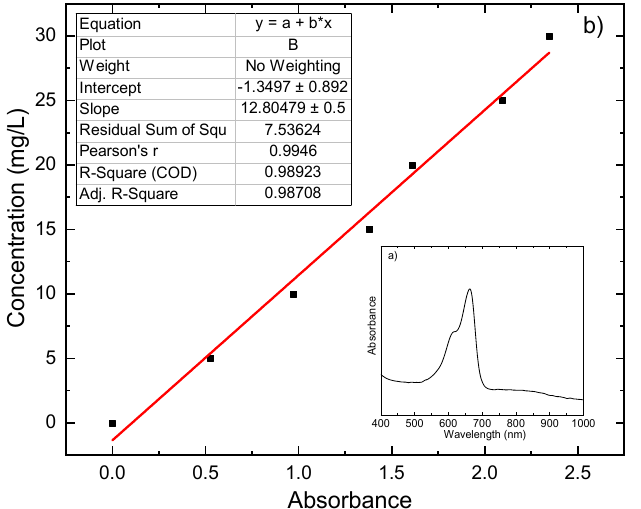
Figure 5. ( a ) The absorbance of MB dye in water solution, ( b ) Concentration vs. absorbance calibration curve for MB dye in water solution.